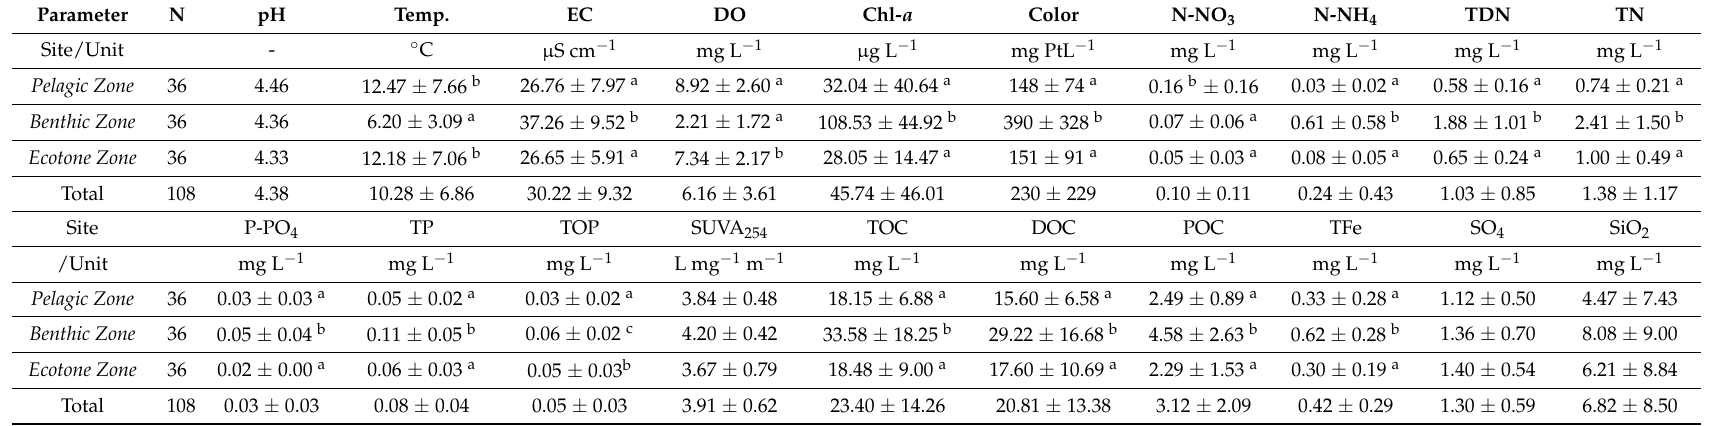
Table 1. Water quality parameters of the studied peat bog lakes. Values represent means ± standard deviation of measurements for three lakes in four seasons over a period of three years. Means bearing different superscripts ( a , b ) differ significantly by the Tukey’s test (post-hoc, ANOVA; p ≤ 0.05); pH—median, N—number of